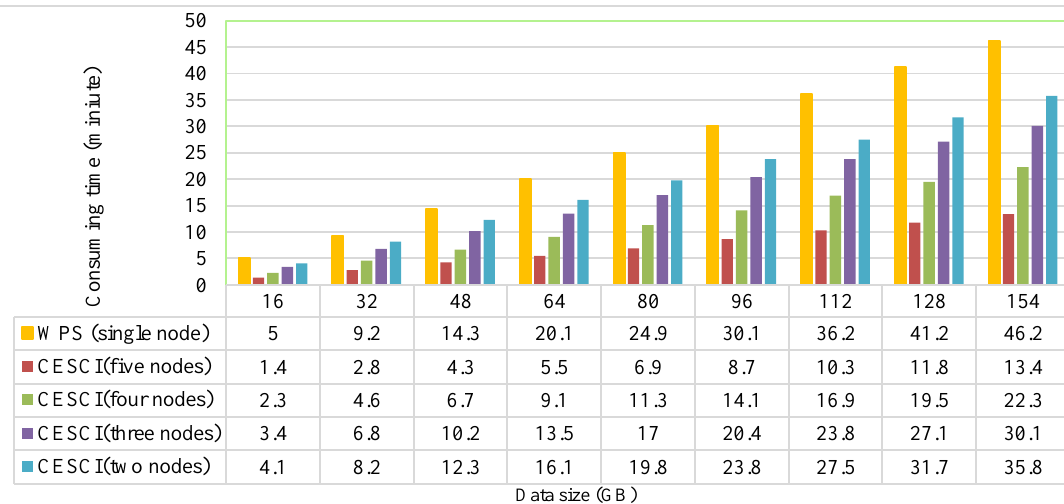
Figure 6. Time consumption associated with mapping the NDVI in Hubei province using the WPS (single node), CESCI (five nodes), CESCI (four nodes), CESCI (three nodes), and CESCI (two nodes) methods.